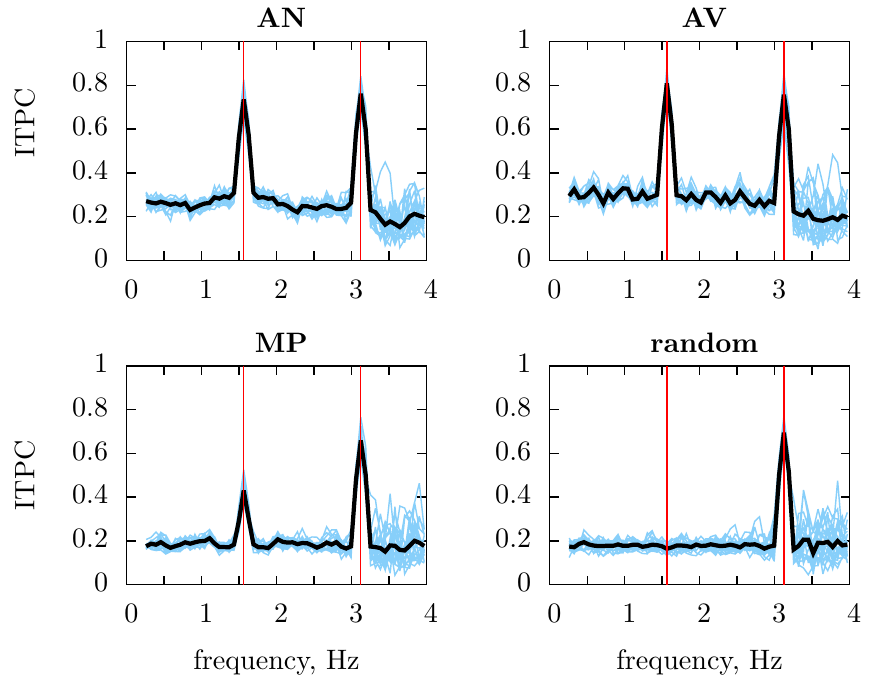
Figure 2. ITPC of the simulated EEG calculated from the word2vec representation for the four conditions. The model yielded peaks in ITPC at the rate of syllable presentation (3.125 Hz) in each of the four conditions (AN, AV, MP, random). Vertical red lines represent the frequency at which syllables and two-word sequences are presented, the blue lines show responses for 20 simulated particants, the black is the grand average over these